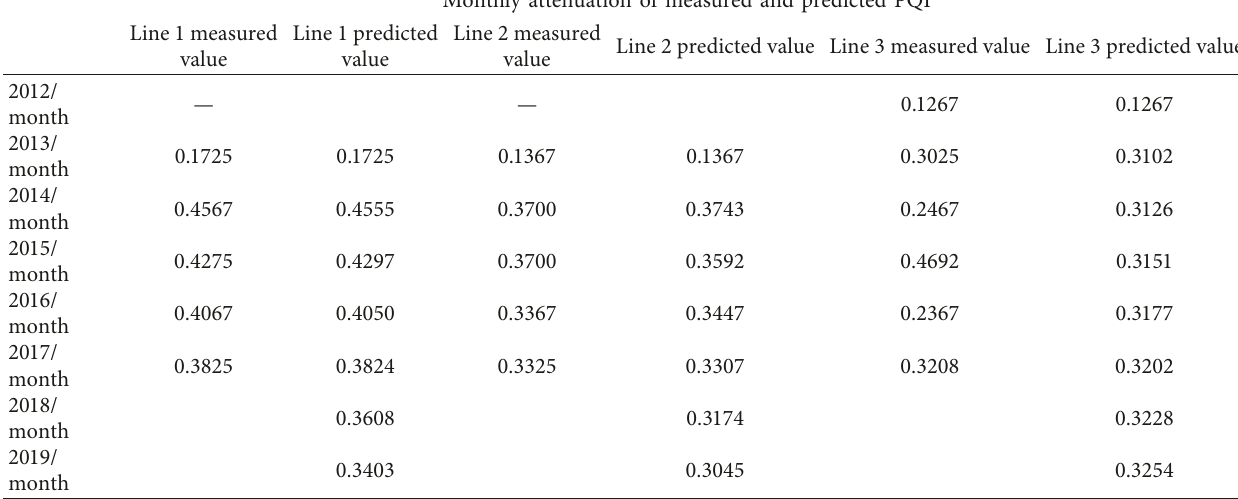
Table 10: Predicted monthly attenuations of PQI for three representative lines of the main trunk highway in Hunan Province. Monthly attenuation of measured and predicted